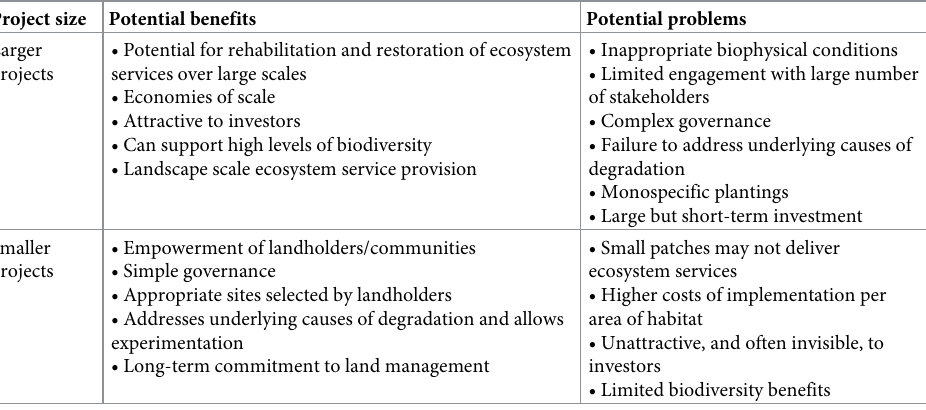
Table 1. Summary of the benefits and problems associated with larger and smaller mangrove restoration